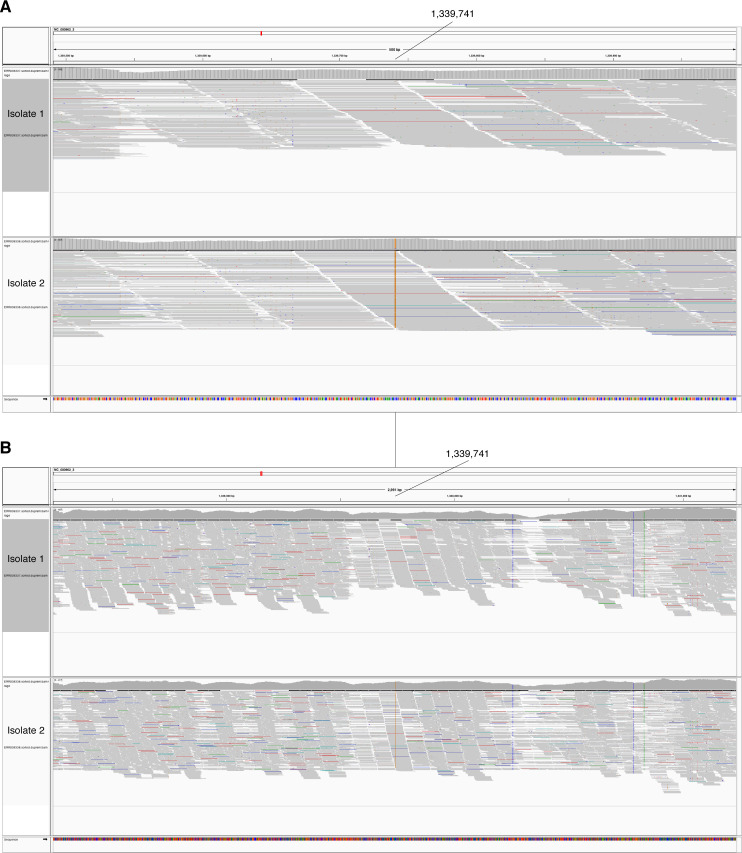
In-host SNP detected in PPE18.IGV (Thorvaldsdóttir et al., 2013) image of BAM alignment (reads sorted by start location) for longitudinal clinical isolates that were cultured from sputum collected from patient P000183 (Walker et al., 2013). (A) 500 and (B) 3000 basepair windows centered at reference position 1339741. Isolate 1 is the BAM alignment for the isolate collected in 2003 and the reference position 1339741 matches the reference allele (C). Isolate 2 is the BAM alignment for isolate collected in 2008 and reference position 1339741 supports an alternate allele (G).